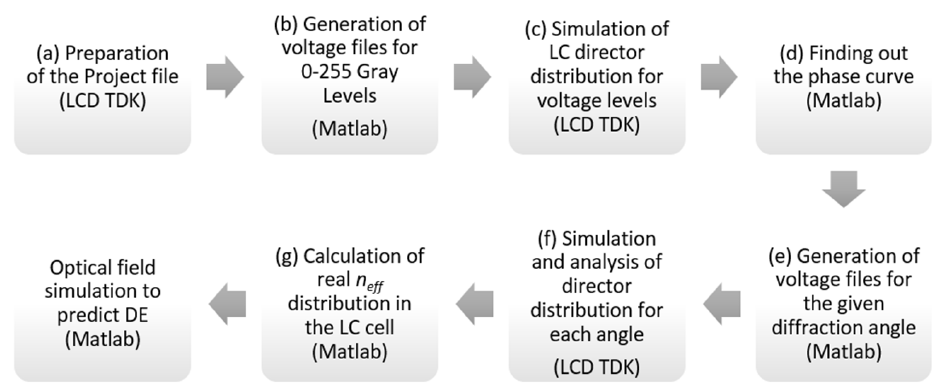
Figure 2. Simulation workflow for the optimization of the phase profile in the BD.s.